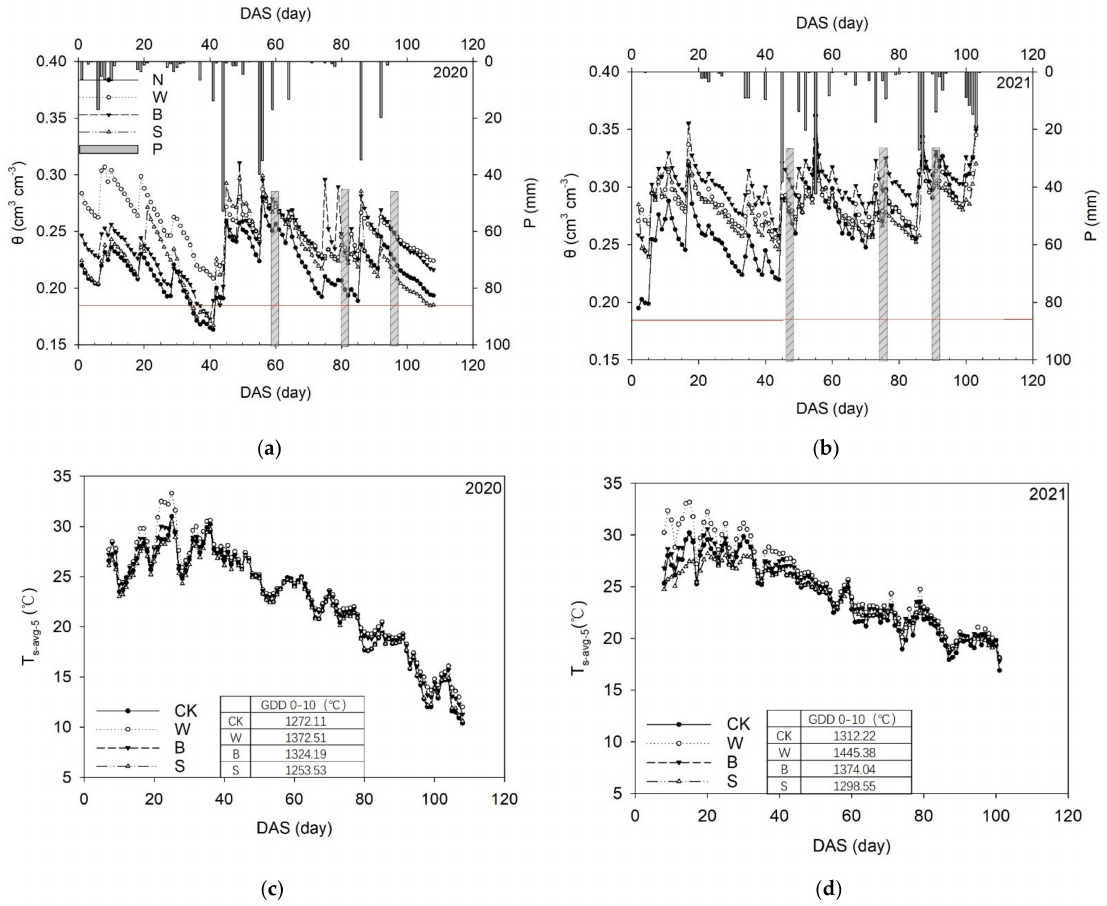
Figure 1. The seasonal dynamics in 0–40 cm soil water content ( θ ) and soil temperature at the depth of 5 cm below ground (T s-avg-5 ) in 2020 ( a , c ) and 2021 ( b , d ). The column with a slash indicates the time of the determination curve. p represents